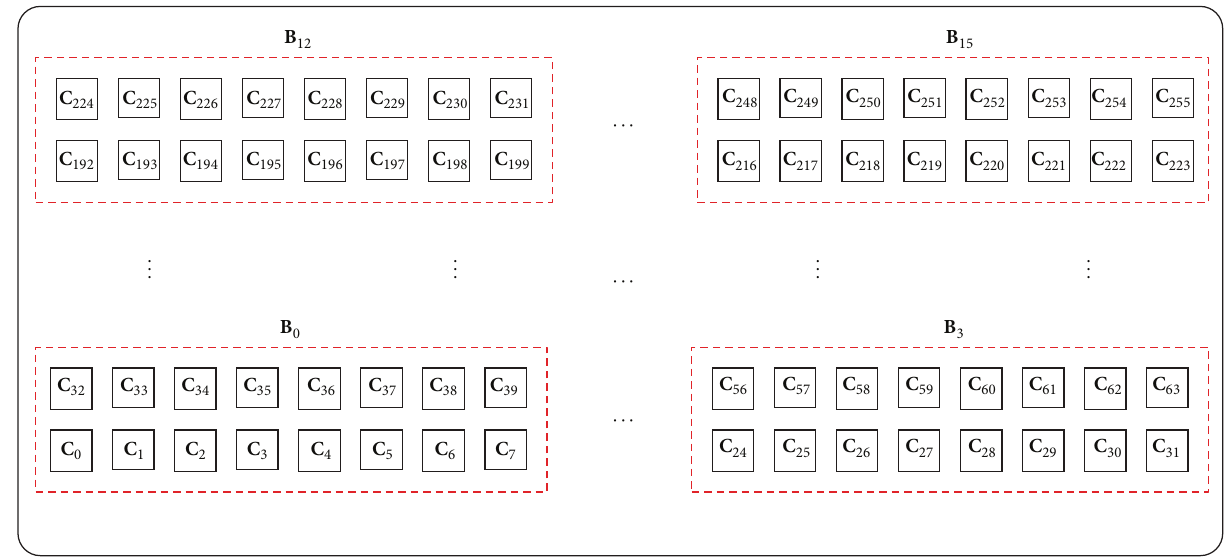
Figure 5: Uniform segmentation of the KPC into several basic beam